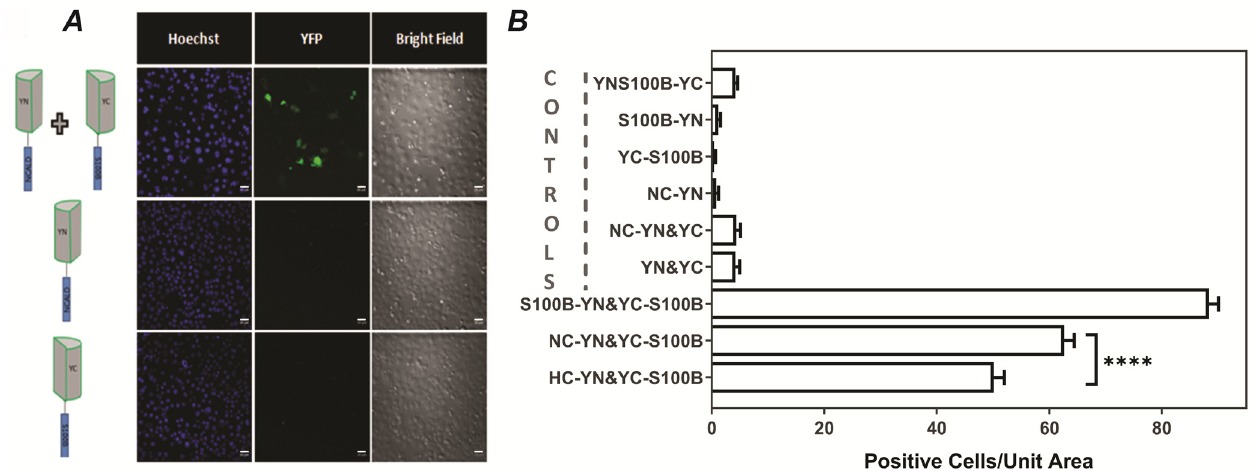
Figure 3. NCALD and S100B interact in living cells: COS 7 cells were cotransfected with constructs NCALD-YN-pcDNA1 and YC-S100B-pcDNA1. Cotransfection of S100B-YN and YC-S100B served as positive control while negative controls include transfection of S100B-YN, YC-S100B, NCALD-YN, YN&S100B-YC, NCALD-YN&YC and YN&YC. Cells were monitored by using Nikon Confocal microscope 48 hours after transfection. ( A ) Images of transfected cells with vectors individually or together ( B ) Analysis of complex formation: Positive cells numbers per unit area were obtained. Data from six independent transfections were pooled for controls; for S100B-S100B, NCALD-S100B and HPCA-S100B, data from twenty independent transfections were pooled and plotted in Prism (9.0). ns p > 0.01; **** p ≤ 0.0001. Scale bar = 50 μ m.